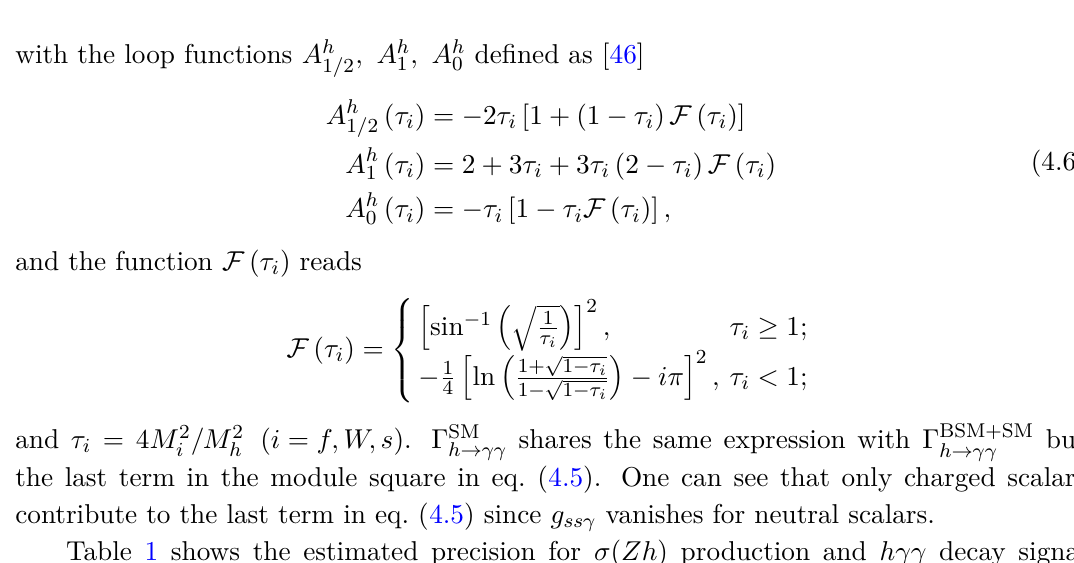
Table 1. Estimated precision of CEPC, FCC-ee and ILC for σ ( Zh ) and h → γγ signal rate. The projected precision for the CEPC and FCC-ee are taken from refs. [5, 6] and those for the ILC are from table 3 in ref. [49], which are rescaled from the luminosity samples of 250 fb − 1 in the ILC operating Scenarios [8, 10, 50]. All quoted values are for statistical uncertainties at the 68% confidence level. The total uncertainty (stat + syst) on the measurement for h → γγ with Higgs production via gluon fusion plus b ¯ bH at the HL-LHC [3] is listed in the last column on the right in comparison of that at the CEPC, FCC-ee and